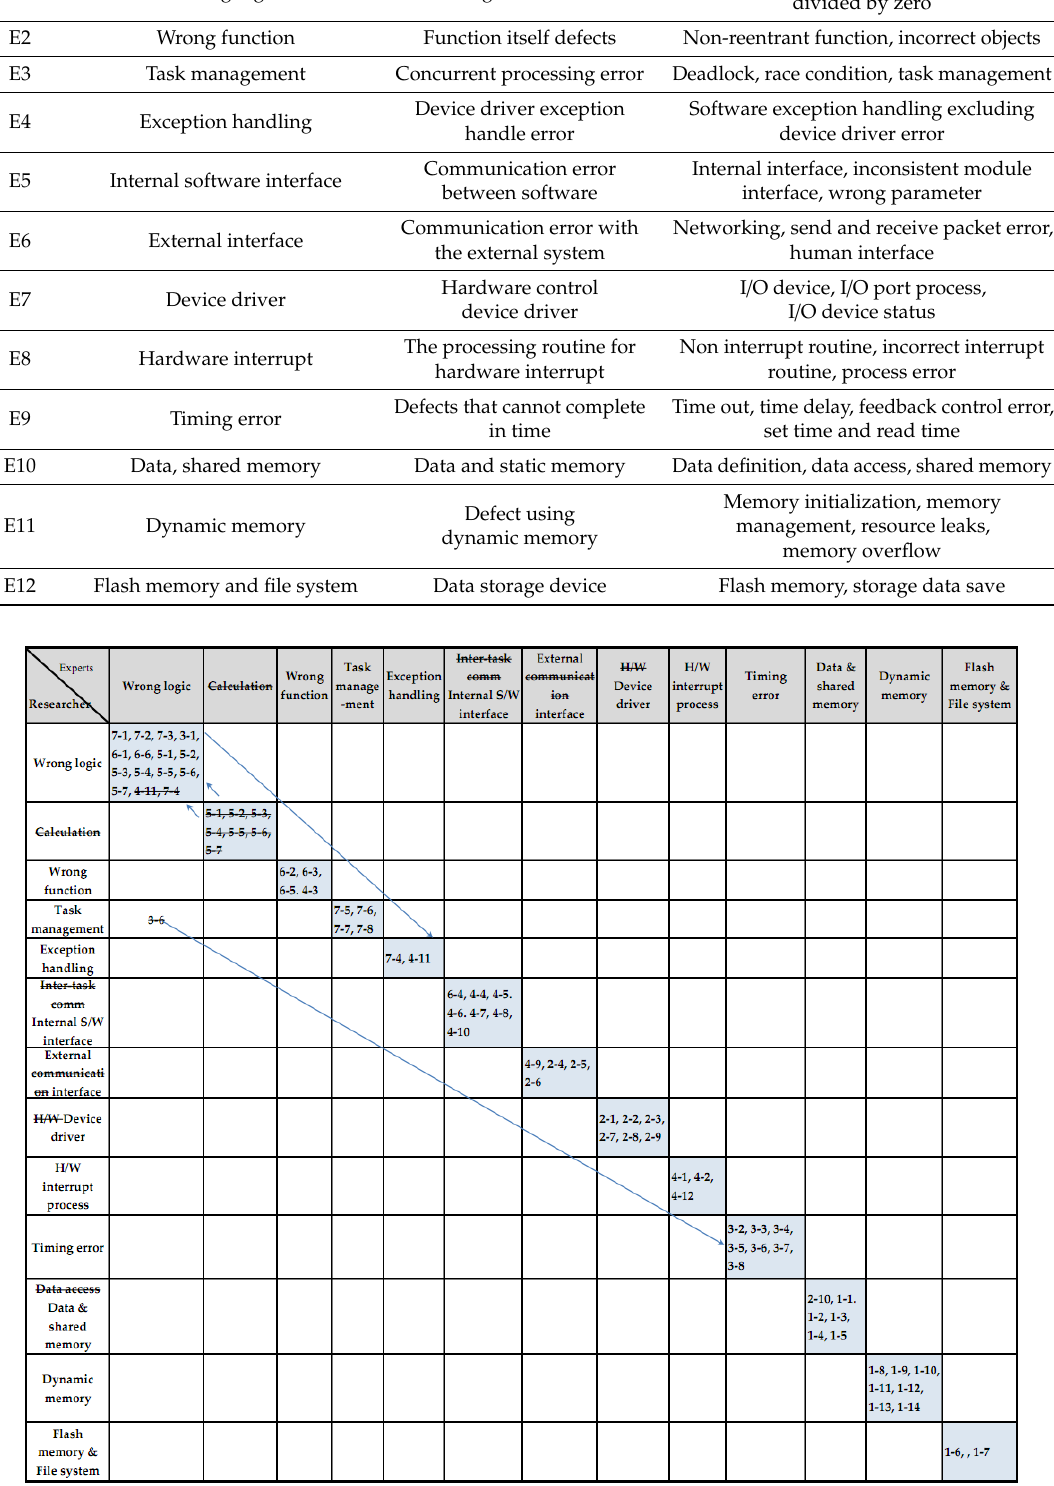
Figure 2. The final reliability table that was agreed upon between the researchers and collaborators based on the standardization of terms shown in Table 7.